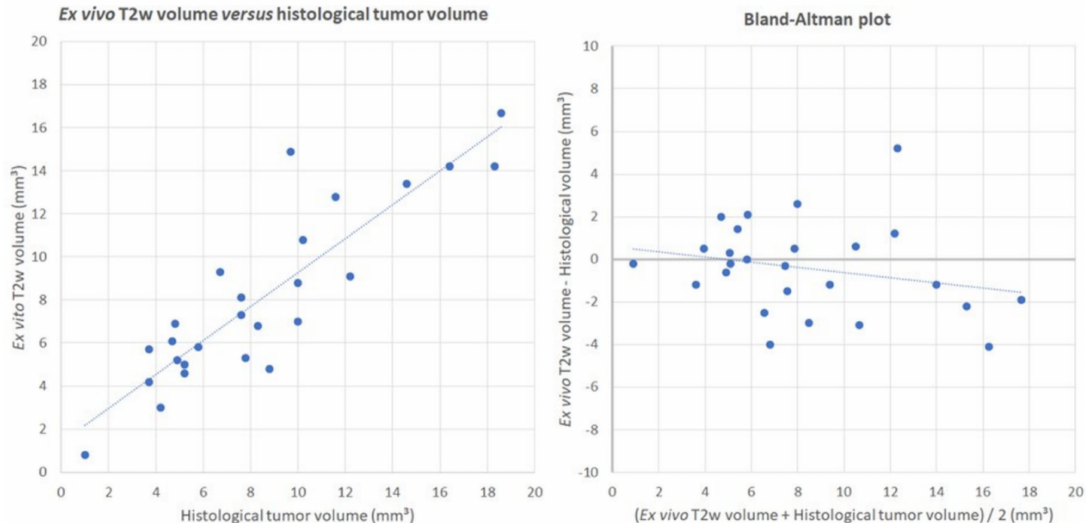
Figure 3. Correlation and difference between ex vivo T2w MRI and histology. These plots visualize the correlation and the difference between volumes of the estimated abnormal mass on ex vivo T2w images and histological tumor volumes. The left plot visualizes the significant strong correlation between the volumes calculated on ex vivo MRI and histology (r = 0.884; p < 0.001). The right plot visualizes the difference between both modalities and indicates that there is no systematic difference between volume estimations from both